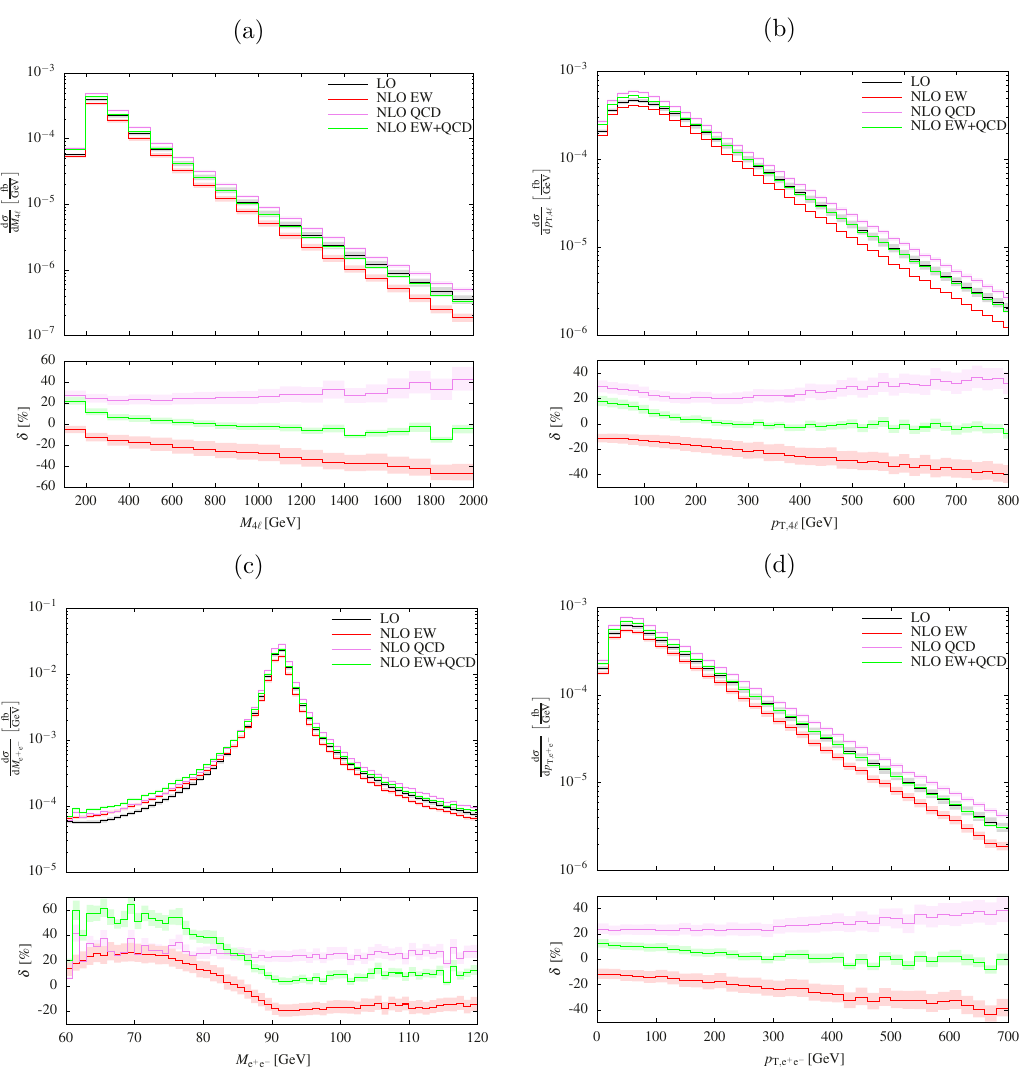
(cid:0) (cid:1) (cid:0) (cid:1) α 6 (LO), O α 7 (NLO EW),